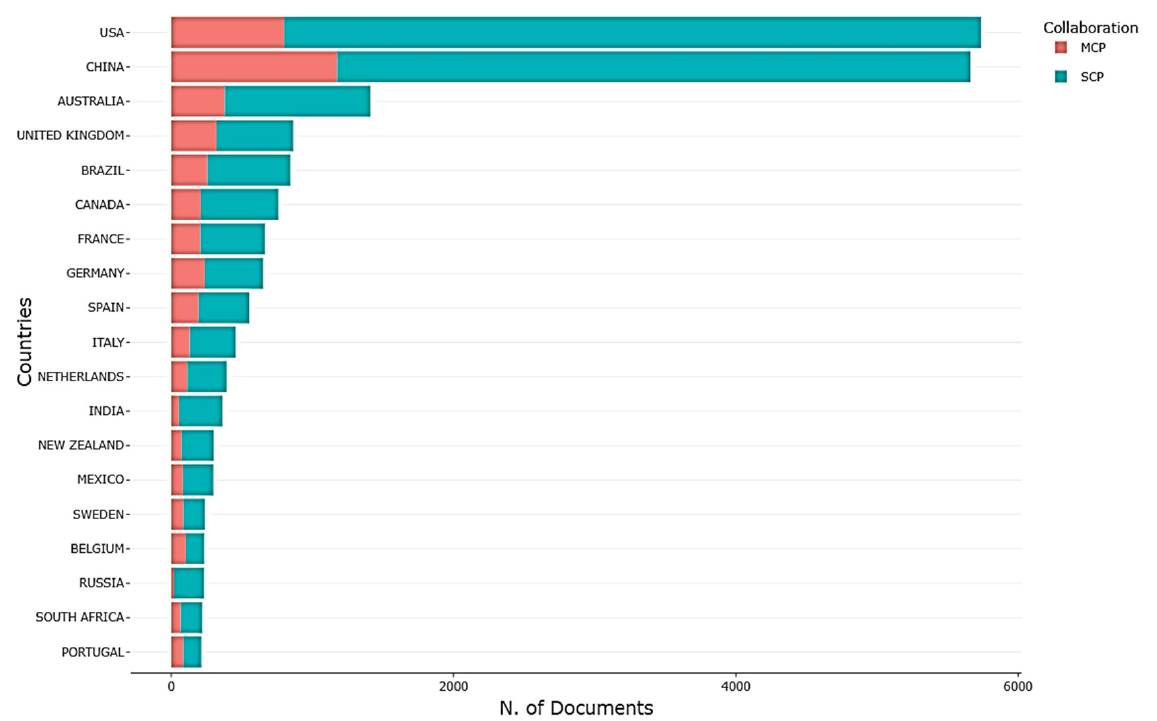
Figure 4. Top 10 countries in terms of literature volume in the field of ecological restoration. MCP = Multiple-country publications; SCP = Single-country publications.